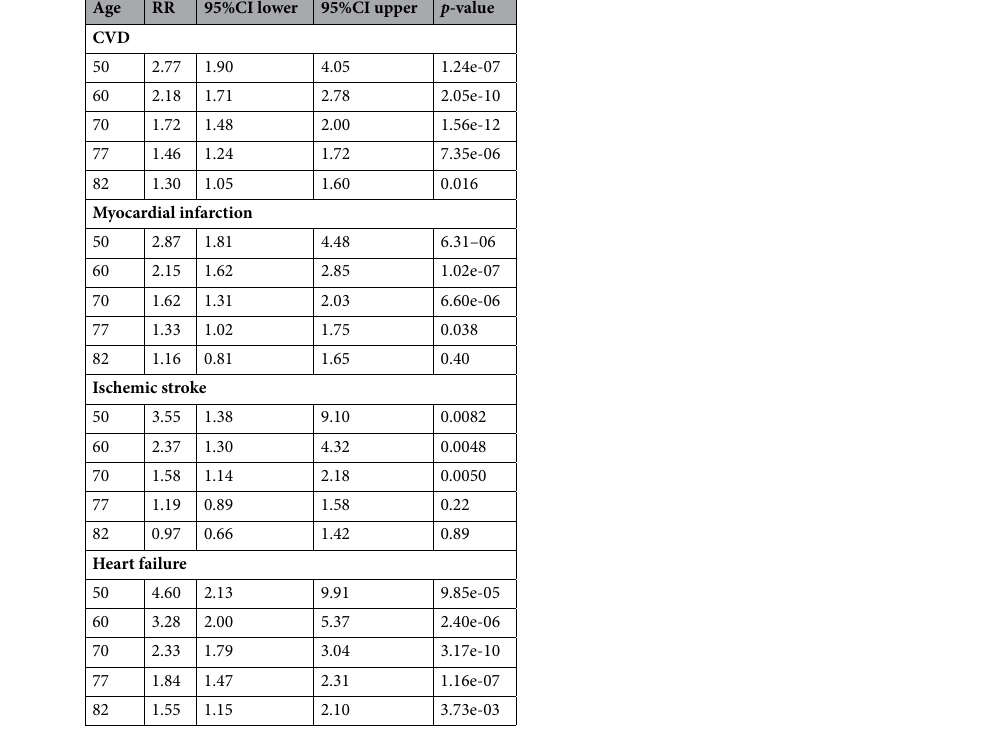
Table 2. Risk ratio (RR), 95%CI and p -value for the risk of incident cardiovascular disease (CVD, combined end-point), myocardial infarction, ischemic stroke and heart failure for prevalent metabolic syndrome (MetS) at different ages. The RRs were adjusted for LDL cholesterol, education level (years in school), leisure time exercise habits, smoking and use of medication against